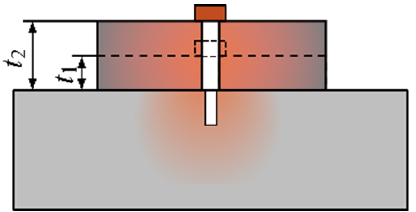
Figure 8. Schematic diagram of the thickness variation of SFLL.